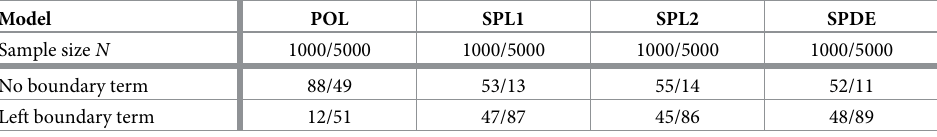
Table 7. Test case 15: Number of realisations out of 100 in which no boundary term or a logarithmic boundary term is chosen for the various semiparametric estimators and different sample